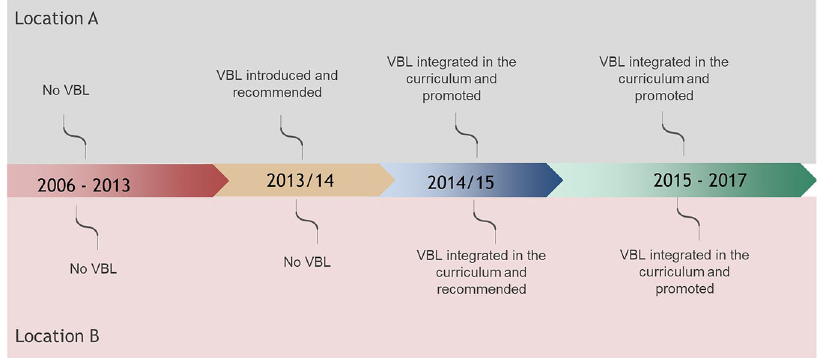
Fig. 2 The Timeline of VBL implementation (2006 – 2017). Stages of introduction and integration of Video Based Learning into the taught curriculum.